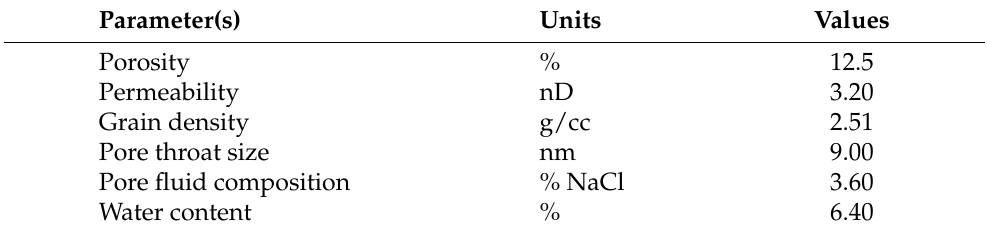
Table 2. Physical properties of Draupne Shale provided by Skurtveit et al. [37] and